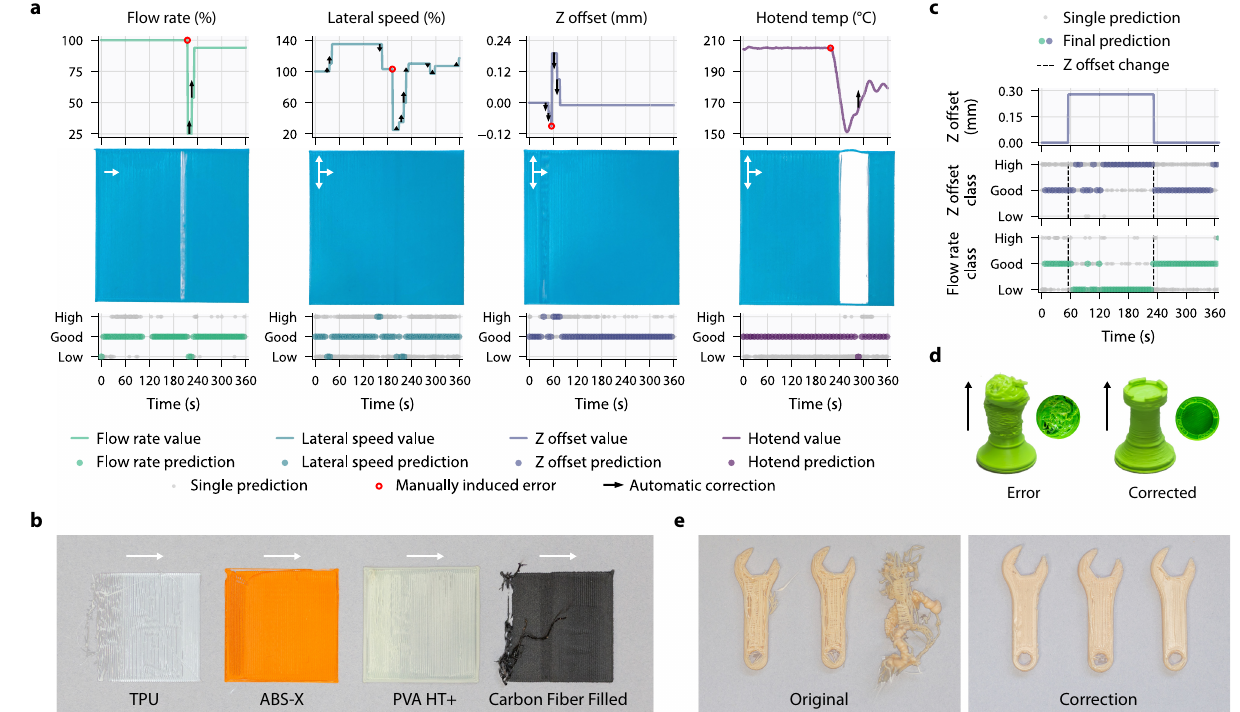
Fig. 4 | Printer and feedstock agnostic online parameter correction and dis- covery.a Rapidcorrectionofamanuallyinducederroneoussingleparameterusing the trained multi-head neural network. Printed with PLA feedstock on a known printer with an unseen 0.4mm nozzle not used in training data. b Online simulta- neous optimisation of multiple incorrect parameters on unseen thermoplastic polymers. Demonstrates that the control pipeline is robust to a wide range of feedstockswithdifferent materialproperties, colourandinitialconditions. c Much